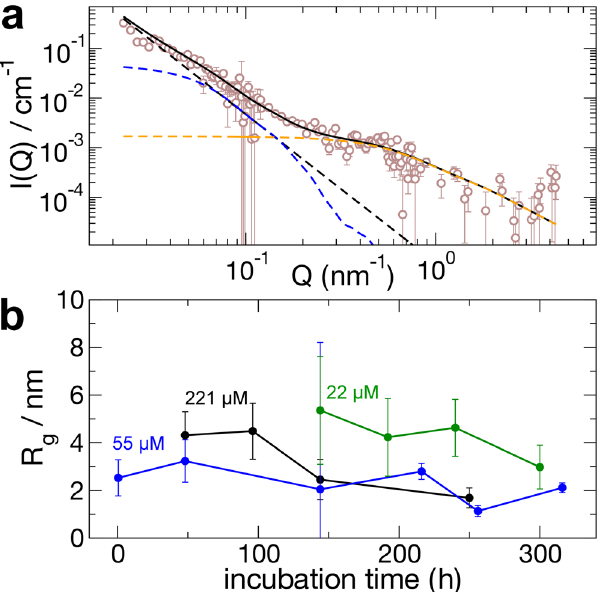
Figure 4. Results from SANS scattering experiments after incubation of A β 42 at pH 7.4. Measurement and incubation was in 50 mM Napi plus 150 mM NaCl in 100% D 2 O at 7 °C. ( a ) Exemplary SANS scattering intensity after 0.5 h. Contributions to the scattered intensity arise from aggregates larger than 50 nm resulting in a power law (black broken line), mid-size aggregates modelled as ellipsoid of revolution (blue broken line) and small oligomers (orange broken line), which are modelled by a Beaucage function. A vanishing background of monomers is modelled as a Beaucage function with fixed R g = 1 nm. The combined fit result is shown as a black solid line. Ellipsoids have radii between 50 and 10 nm. ( b ) The radius of gyration of small oligomers from SANS analysis after incubation at concentrations of 221 μ M (black), 55 µ M (blue) and 22 µ M